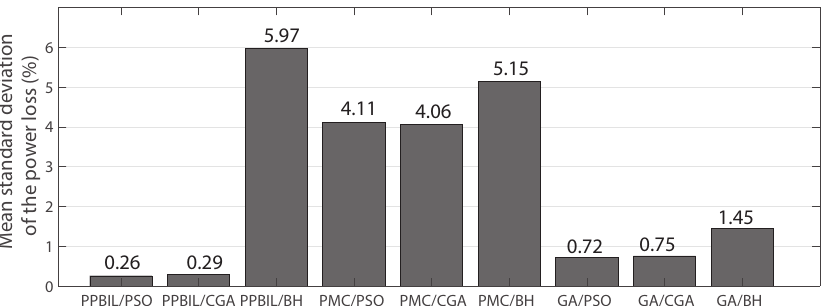
Figure 8. Mean standard deviation of the power loss for the 10 bus test